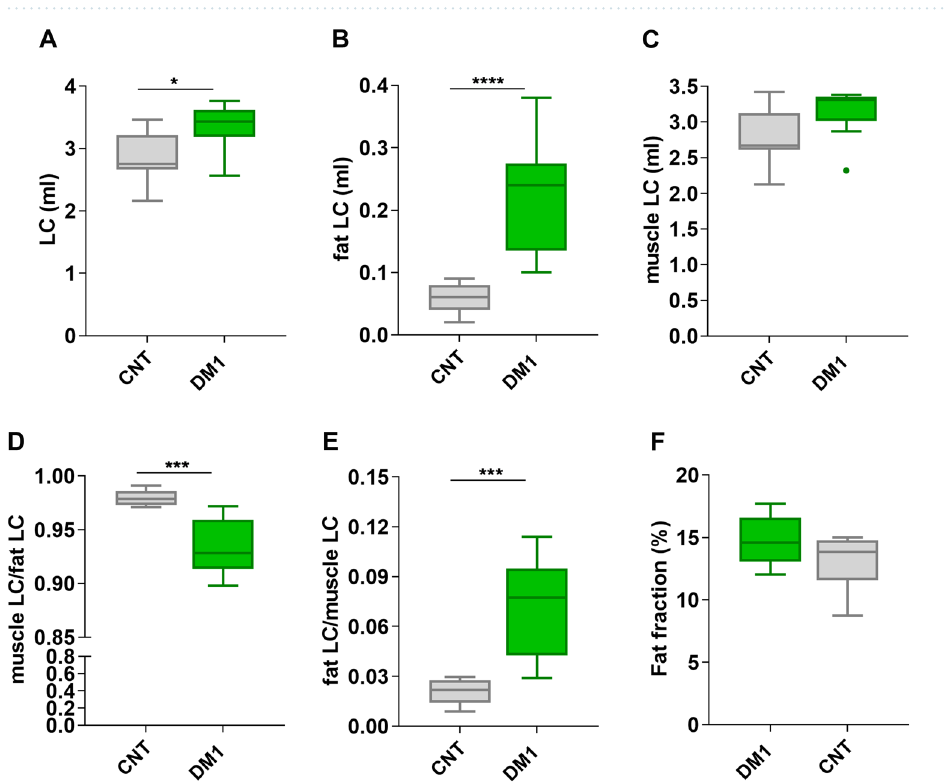
Figure 4. HSA LR mice display fat infiltration in skeletal muscle. Plots represent the total volume ( A ), the volume of fat ( B ), and the volume of muscle ( C ) in the leg compartments of control (CNT) and DM1 model mice. Values were obtained from quantitative analyses of MRI data (n = 9 mice per group). Muscle-to-fat ratios ( D ) were also calculated. Disease model mice showed increased fat infiltration levels in skeletal muscle ( E ). No differences in the fat fraction were detected between control and model mice ( F ). The boxes extend from the 25th to the 75th percentile, the line in the middle of the box is plotted at the median, and the whiskers reach down to the smallest value and up to the largest. *p < 0.05, ***p < 0.001, ****p < 0.001 according to a 2-tailed Mann ‒ Whitney U